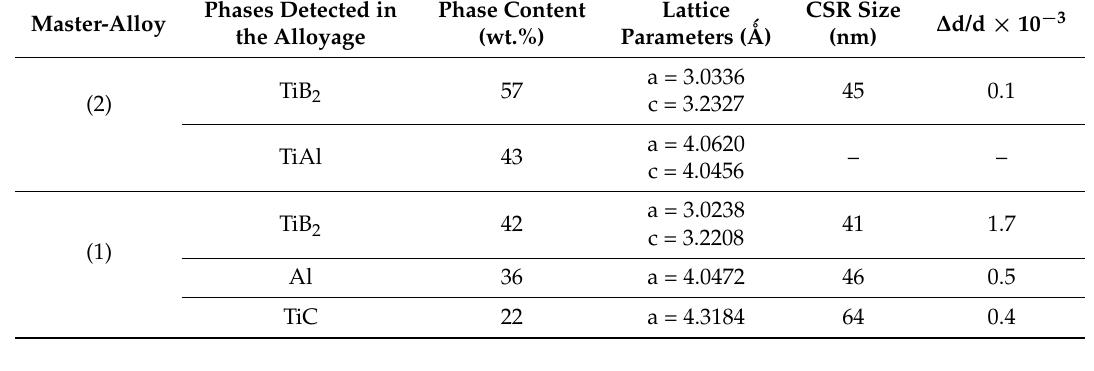
Table 1. The data of the phase analysis of SHS master alloys containing TiB 2 and TiC particles. Master-Alloy